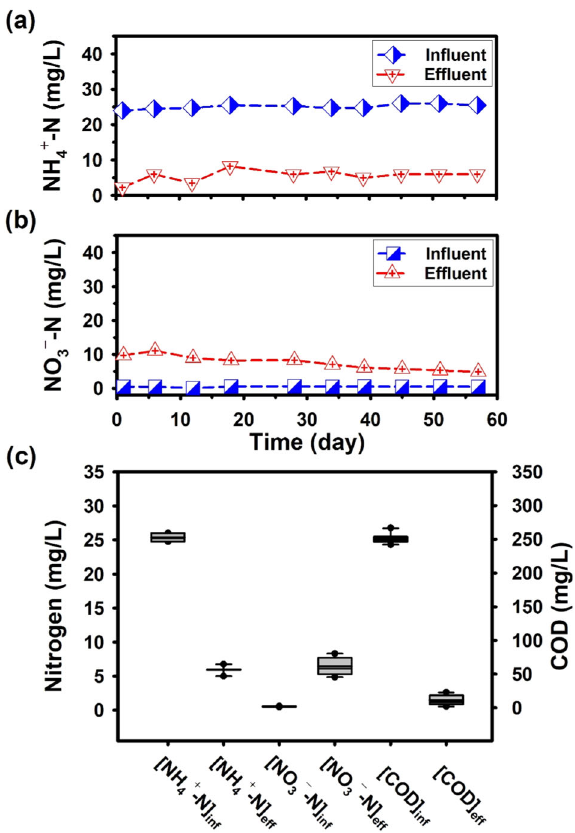
Fig. 2 Nitrogen concentration pro fi les of the IBPR in IA mode. The in fl uent and ef fl uent concentration pro fi les of a NH 4 + -N, b NO 3 − -N over time, and c box plot comparing the average in fl uent and ef fl uent concentrations of nitrogen species and COD during the operation of the IBPR in intermittent aeration mode. Box plot of line, the box and whiskers represent median, 25th and 75th, 10th and 90th percentile of the data during the period of IA